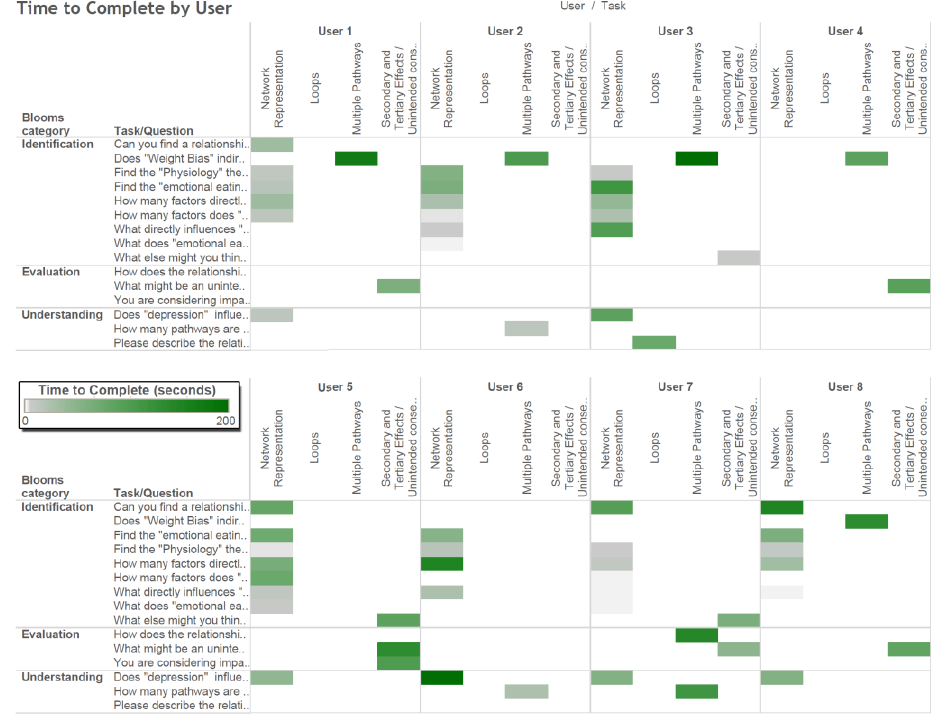
Figure 8. Time to complete each task for each user. Darker colors indicate a longer time to completion.